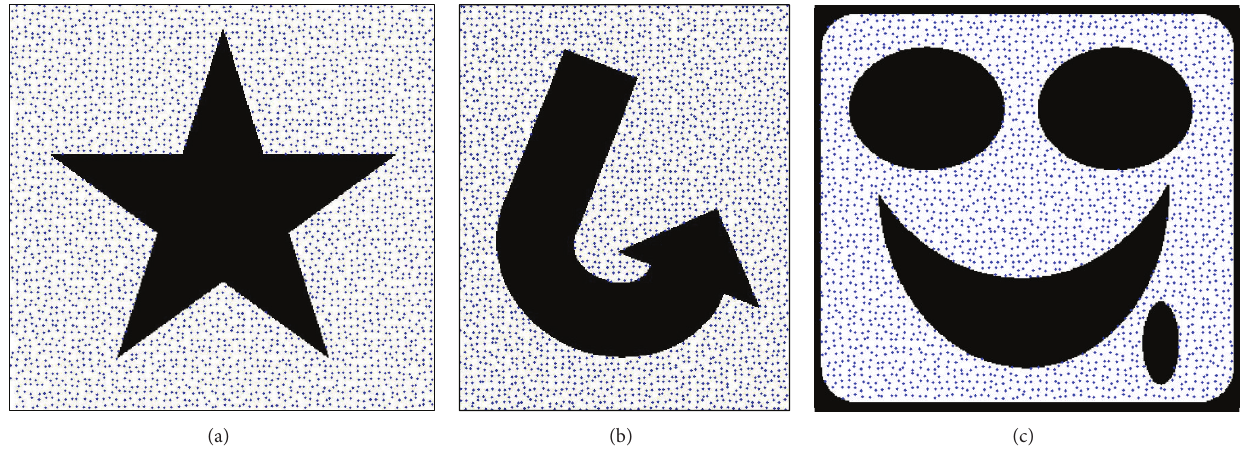
Figure 1: Sensor nodes deployed in geometric